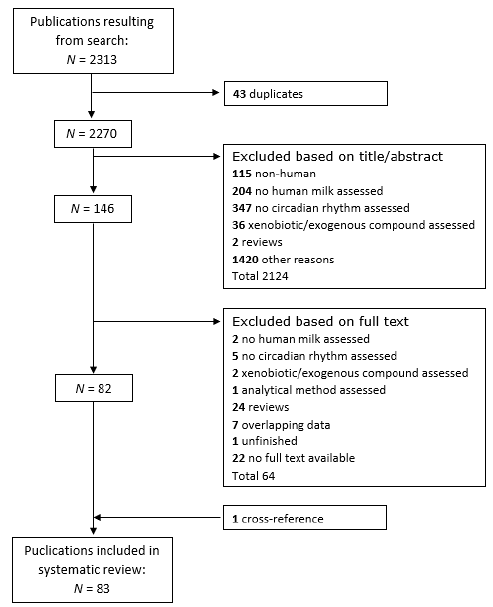
Figure 1. Flowchart of a study selection based on the inclusion and exclusion criteria.